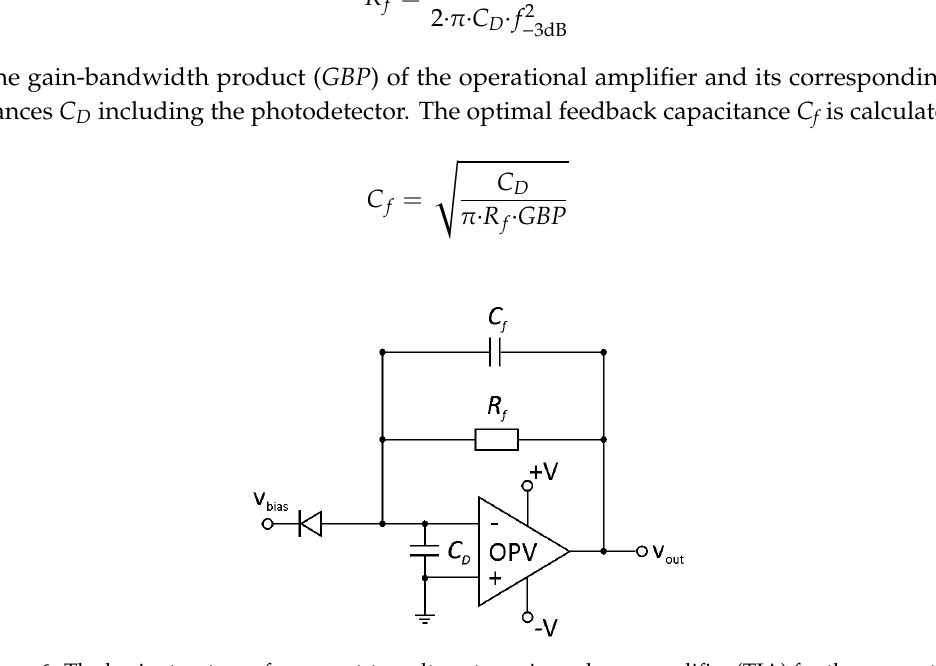
Figure 6. The basic structure of a current-to-voltage trans-impedance amplifier (TIA) for the connection of a biased photodiode.